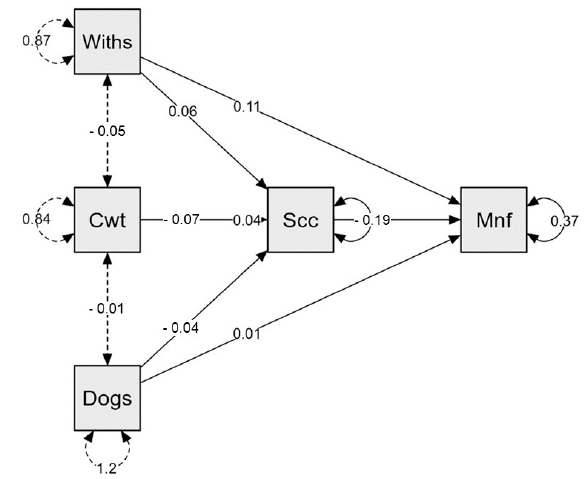
Figure 3. Path analysis model for the mediating effect of challenges on HCWs’ demographics and coping strategy adoption during the COVID-19 pandemic. Note: Withs = Working in this hospital (experience), Cwt = Current working type, Dogs = Distance to green spaces from accommodation, Scc = Societal challenges, Mnf = Meaning focused .